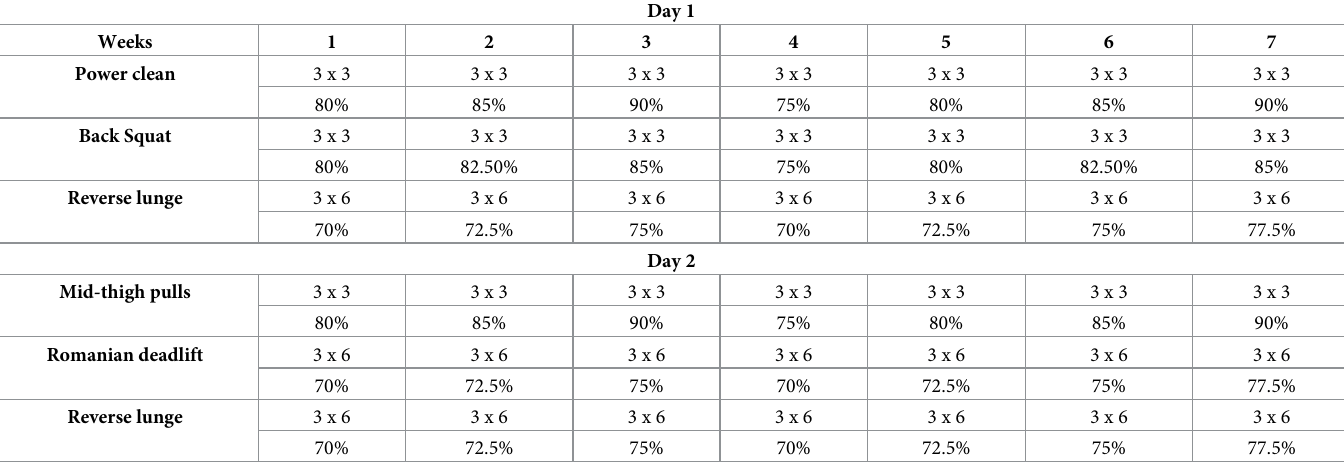
Table 1. Lower limb resistance training programe, including sets x reps and estimated one repetition maximum percentages, performed by the control and inter- vention groups across the seven-week training